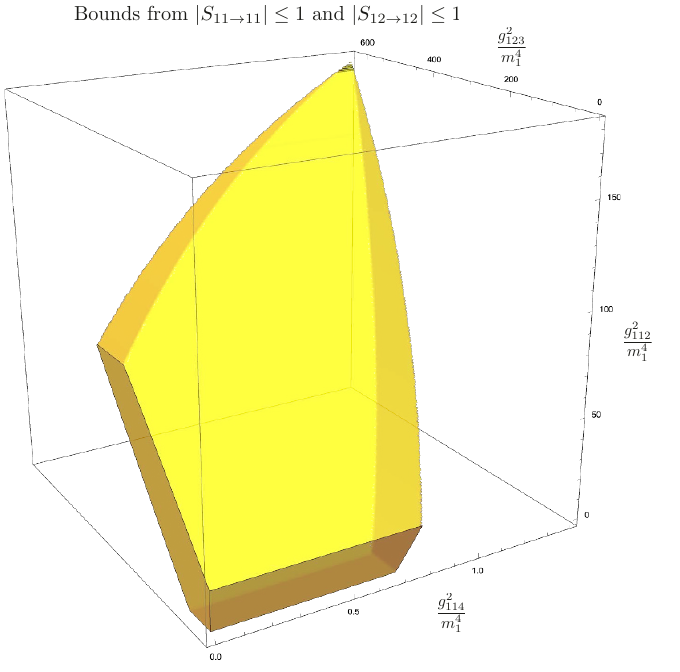
S 11 11 j (cid:20) 1 and j S 12 j !